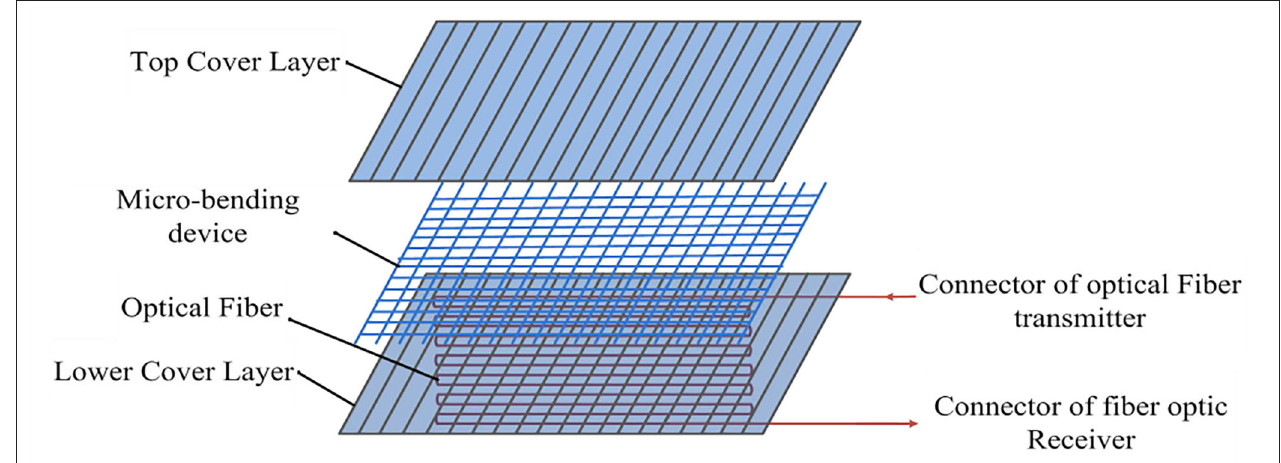
FIGURE 3 | Internal structure of the optical fiber